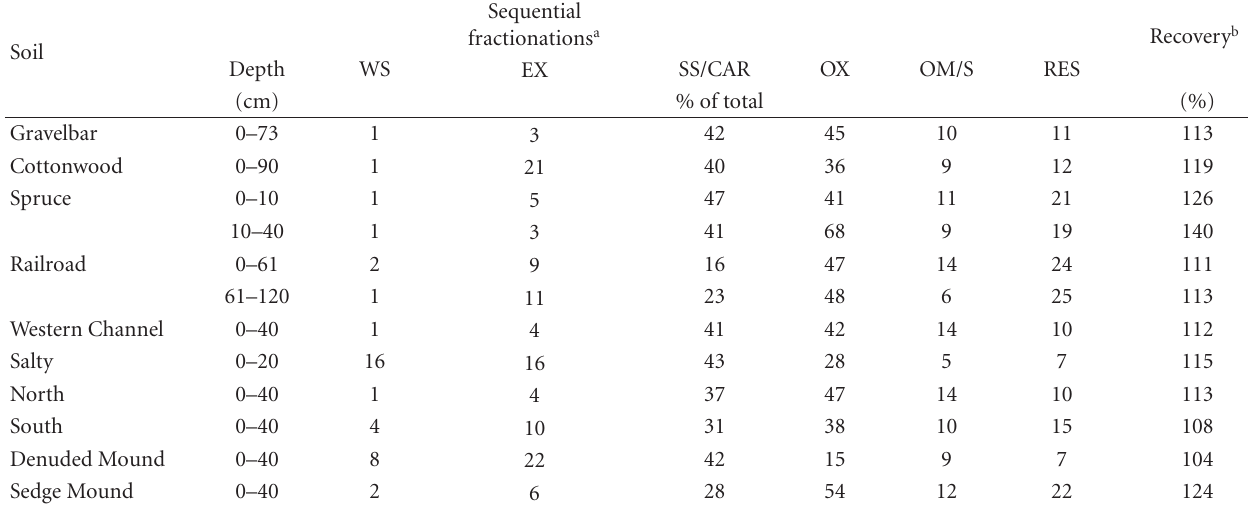
Table 9: Sequential extraction as percent of total extractable trace elements (TE) in study soils.